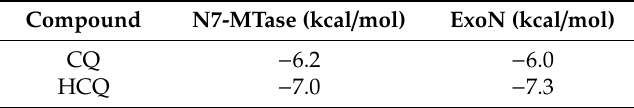
Table 1. Calculated free binding energies ( ∆ G B , in kcal / mol) of CQ and HCQ in N7-MTase and ExoN